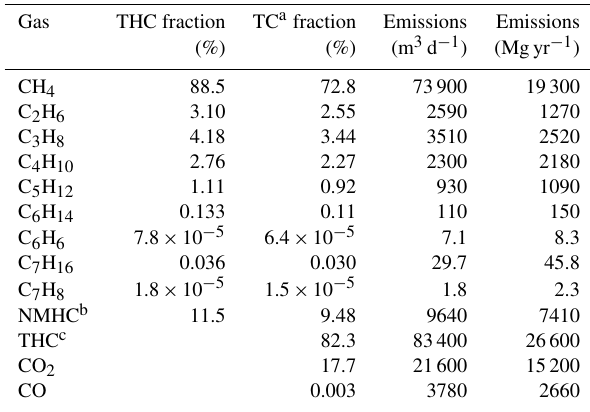
Table 1. Atmospheric plume composition and model atmospheric